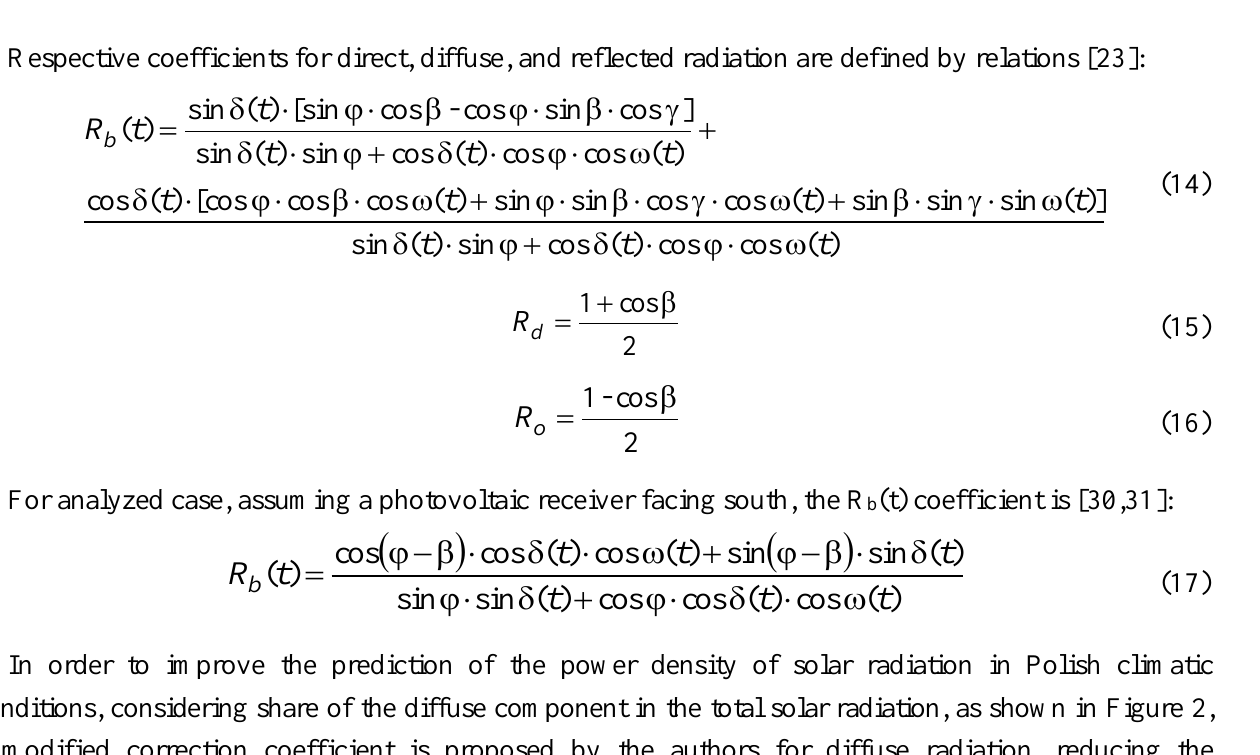
Figure 1. Two-axis tracking system with photovoltaic module, radiation power density meter and